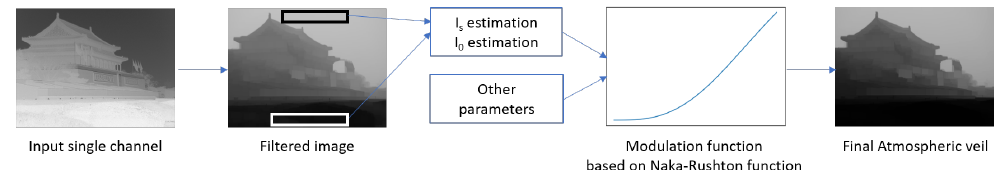
Figure 6. Atmospheric veil estimation from the morphologically filtered pre-veil using Naka–Rushton as a modulation